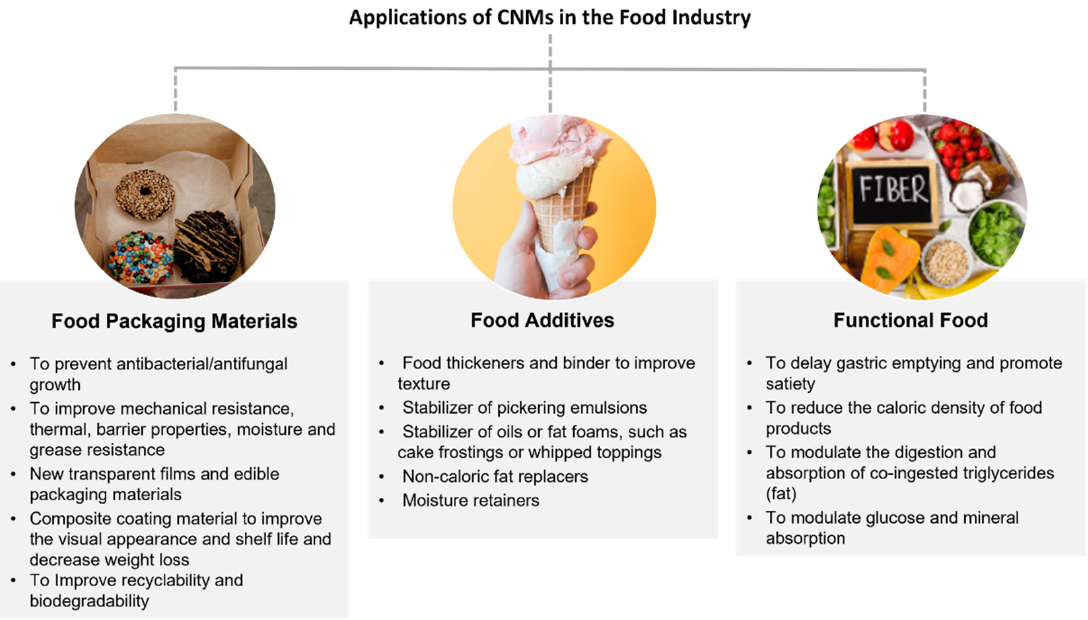
Figure 2. Potential applications of CNMs in the food industry, including food contact materials.